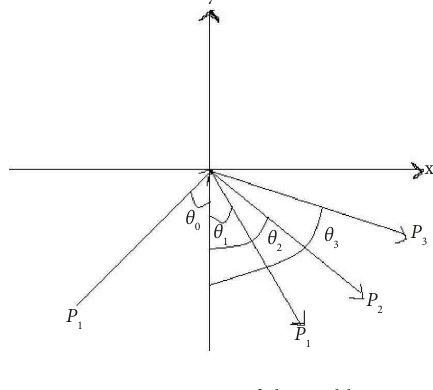
Figure 1: Diagram of the